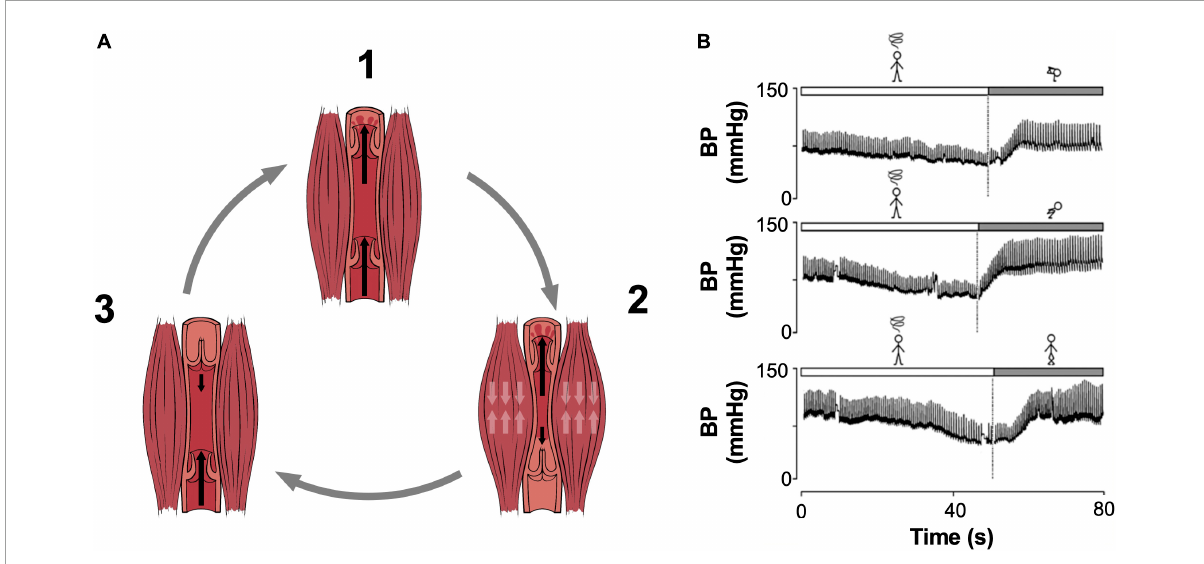
FIGURE2 The Skeletal Muscle Pump. (A) Pumping cycle of the skeletal muscle pump is shown. (1) Prior to contraction, venous valves are open, and blood freely enters the vessel. (2) Muscular contraction compresses the vessel, forcing blood through the superior valves, meanwhile inferior valves close to prevent backflow. (3) With relaxation, negative pressure closes the superior valves and blood is drawn into the vessel through the inferior valve in preparation for the next cycle. (B) Representative sample tracings of pressure responses to the crash position (top; squatting with the head placed between the knees), squatting (middle), and leg crossing performed with buttock and abdominal tensing (bottom). The patient performed these maneuvers following a vasovagal reaction accompanied by prodromal pallor and sweating. All three maneuvers successfully restored blood pressure. BP, blood pressure. Adapted from (A) OpenStax College, Anatomy and Physiology (133) (licensed under the Creative Commons Attribution 3.0 Unreported license) and Boron and Boulpaep, Medical Physiology (27), (B) Krediet et al.